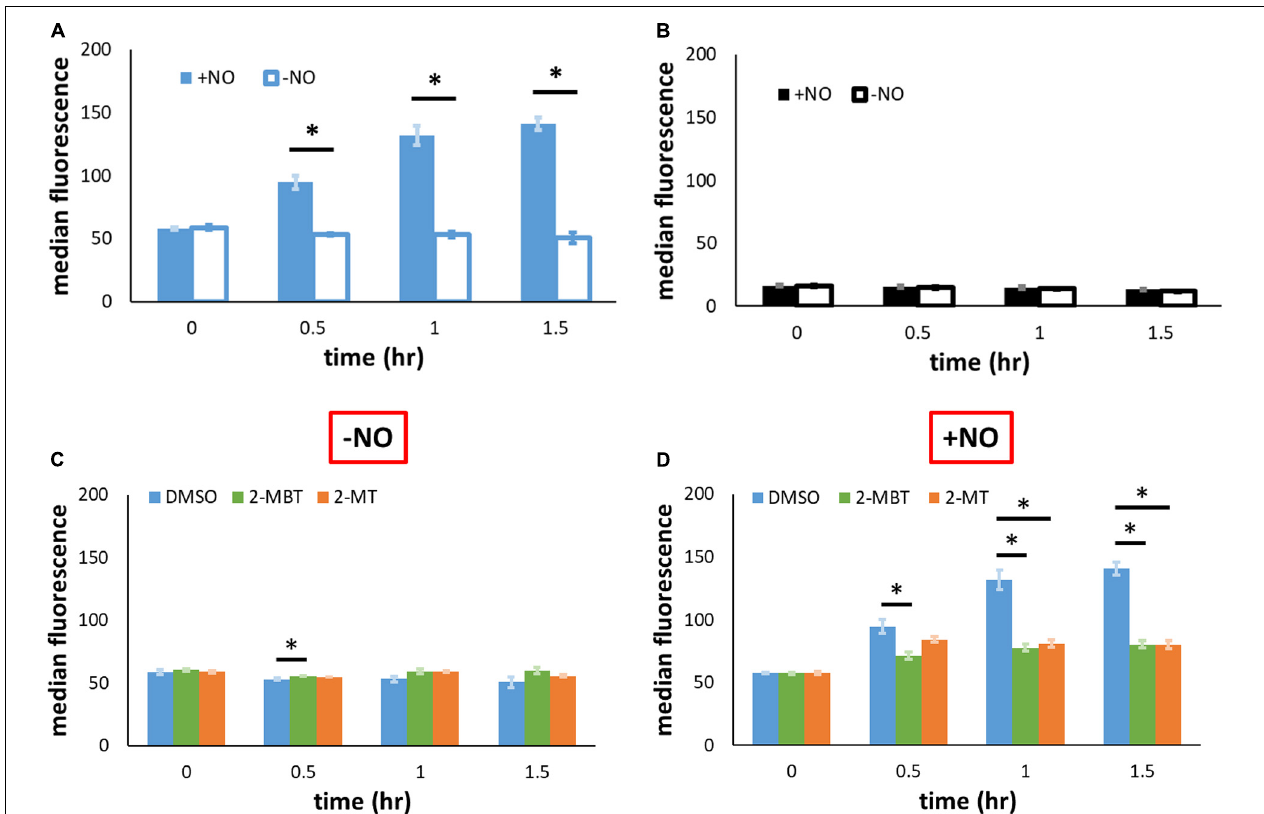
FIGURE 8 | Protein output from P hmp in the absence and presence of NO with and without inhibitors. (A,B) To validate that the induction of GFP synthesis in the presence of NO was specific to the native promoter of hmp (P hmp ), gfp SF from the hmp promoter (pWC04) in imp4213 (cid:49) hmp was monitored by fluorescence in (A) , whereas a promoterless reporter construct (pUA66) was monitored fluorescently in (B) . (C,D) To examine the effect of compounds on the output from P hmp , fluorescence in imp4213 (cid:49) hmp harboring pWC04 was monitored in the absence (C) and presence of NO (D) . Values reported here are the median fluorescence of 100,000 cellular events. Solid bars represent the mean of the median from at least 3 independent experiments, and the error bars the standard errors of the means. The asterisk sign (*) indicates significant difference in fluorescence between compared groups. Statistical significance between compared pairs was determined by performing t -test using the p -value threshold of 0.05. When more than 2 conditions were compared, significance was determined by first running a one-way ANOVA test across all treatment conditions at the same time point. When the p -value from the ANOVA test was lower than 0.05, difference between groups were assessed by performing Tukey’s test, with a p -value threshold of